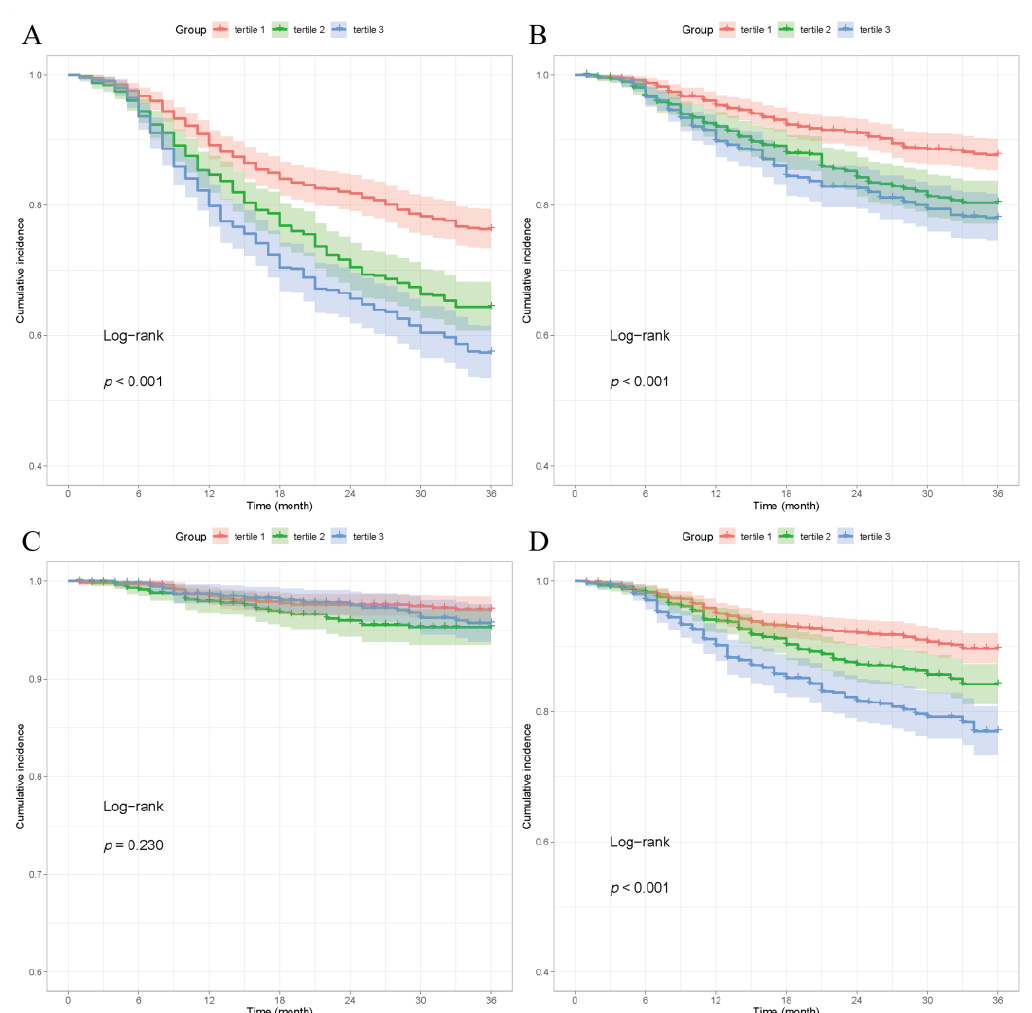
Figure 2. ( A ). Kaplan – Meier curves showing the association between the RDW tertiles and MACE. ( B ). Kaplan – Meier curves showing the association between the RDW tertiles and all-cause mortality. ( C ). Kaplan – Meier curves showing the association between the RDW tertiles and nonfatal MI. ( D ). Kaplan – Meier curves showing the association between the RDW tertiles and any revascularization. Abbreviations: RDW: red blood cell distribution width; MACE: major adverse cardiovascular events; MI: myocardial infarction.